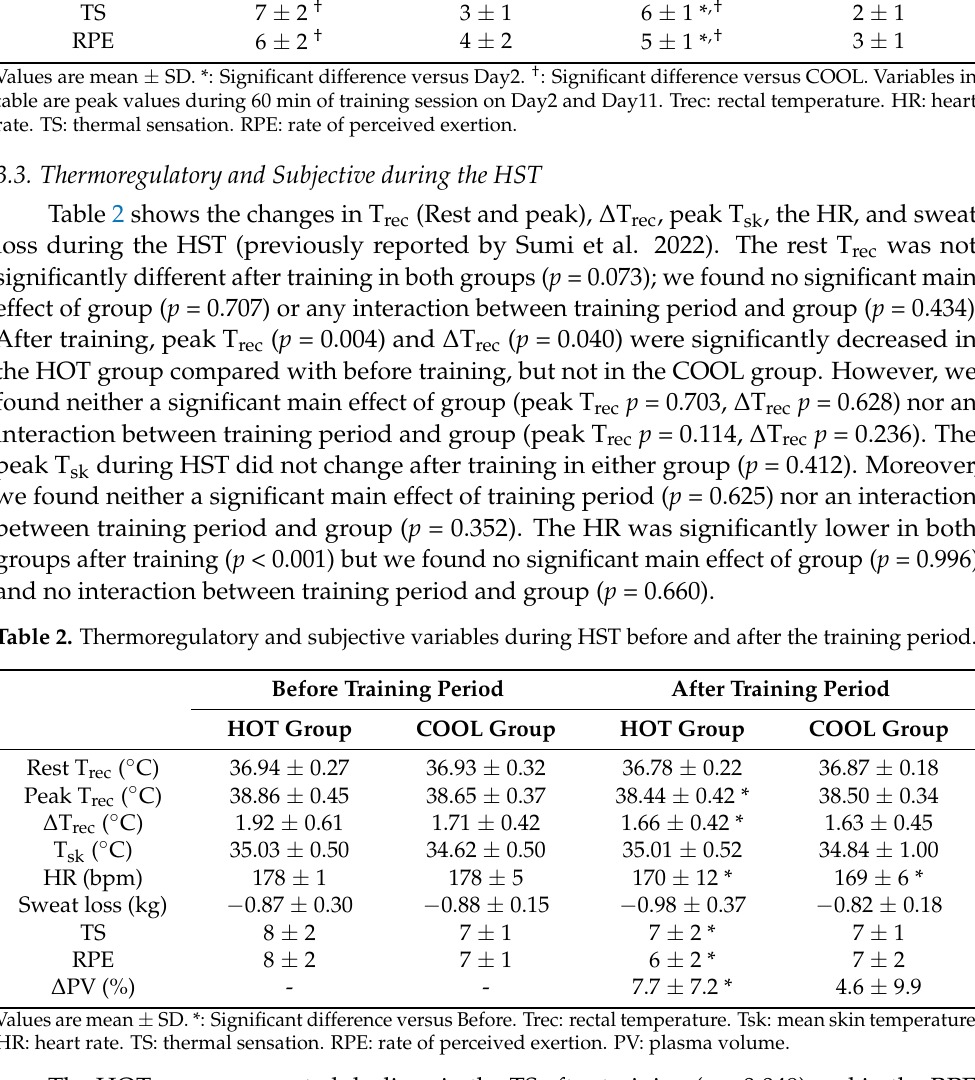
Table 1. Thermoregulatory and subjective variables during endurance training. Day2 Day11 HOT Group COOL Group HOT Group